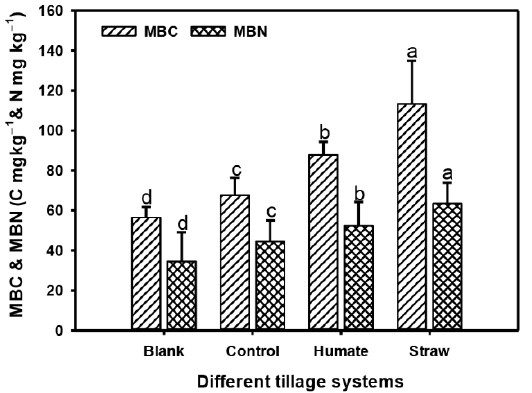
Figure 3. Influence of the humate and straw treatments on the MBC and MBN of the 0–20-cm soil layer in 2018 at the end of the 3-year trial. Significant differences are indicated by lowercase letters (a, b, c) according to LSD test at p < 0.05 level. Error bars represent the standard deviation (SE).